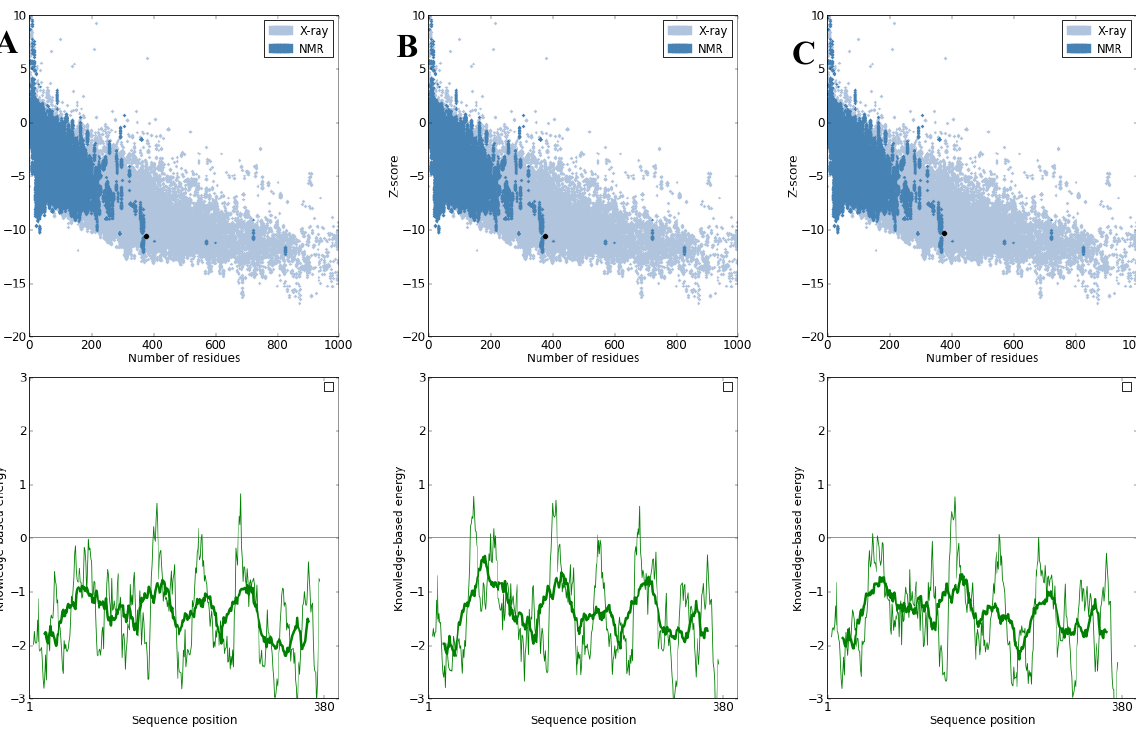
Figure 5. Protein quality scores for ( A ) NBD protein; ( B ) K71L and ( C ) T204V mutants generated through ProSA web server. The results generated display the Z-scores which indicate the overall model quality and energy plots which indicate the local model quality. PROSA-web Z-scores of all protein chains in PDB are determined by X-ray crystallography (light blue) and NMR spectroscopy (dark blue) with respect to their length. The Z-score of protein models were present in the range represented by the large black